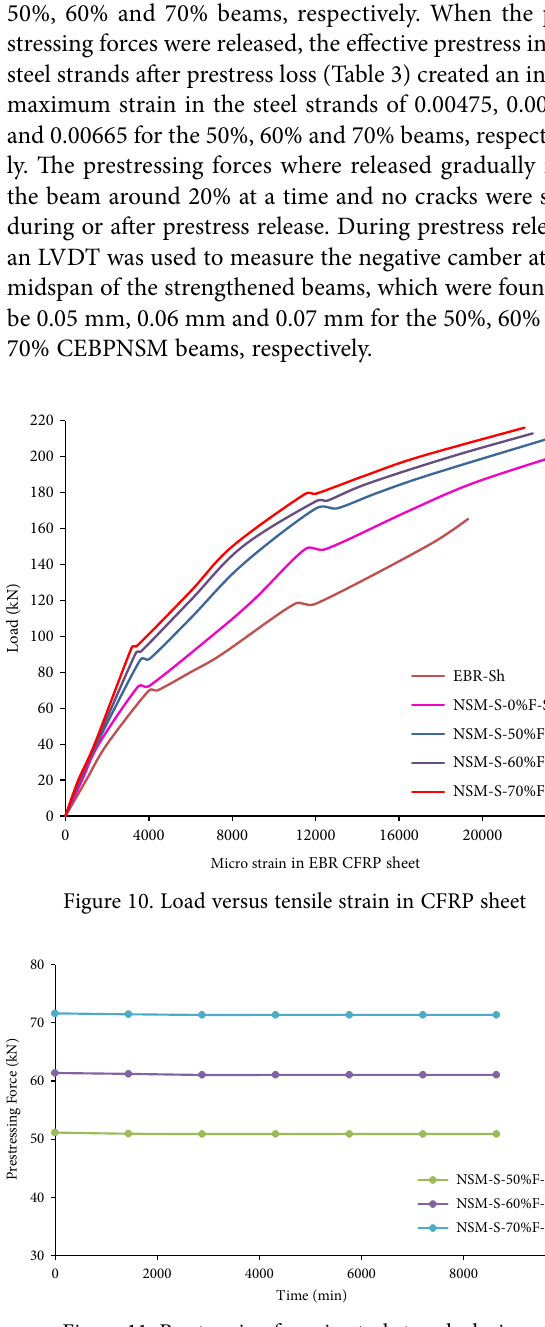
Figure 11. Prestressing force in steel strands during curing period